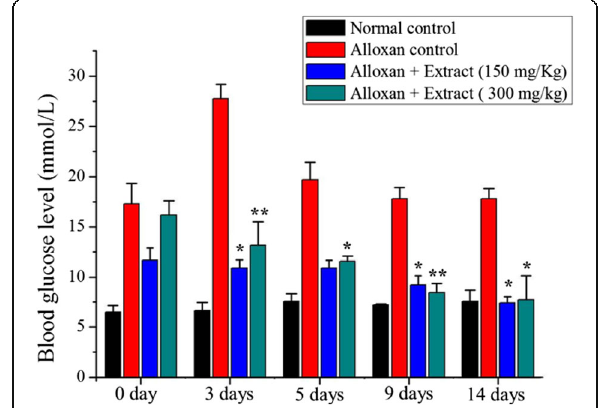
Fig. 8 Effect of C. crepidioides extract on alloxan-induced diabetic rats. Values were represented as mean ± SD ( n = 6). * p < 0.05 and ** p < 0.01 as compared with the alloxan control